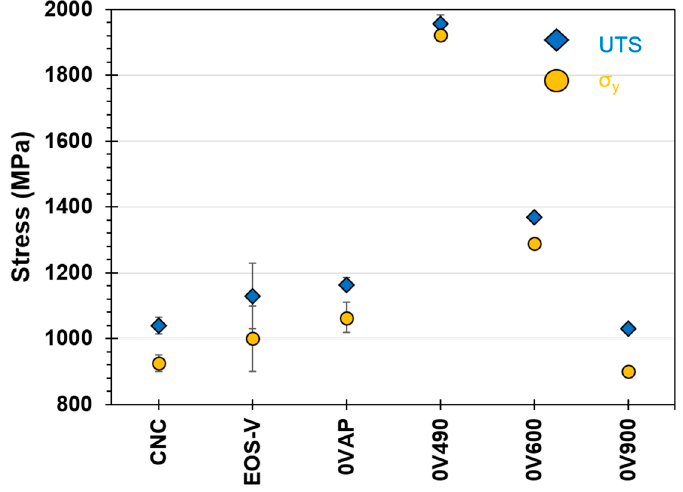
Figure 3. Ultimate tensile strength of as-printed and heat-treated specimens printed in the V orientation and unexposed. Values are compared to CNC maraging steel and EOS benchmark values [22].